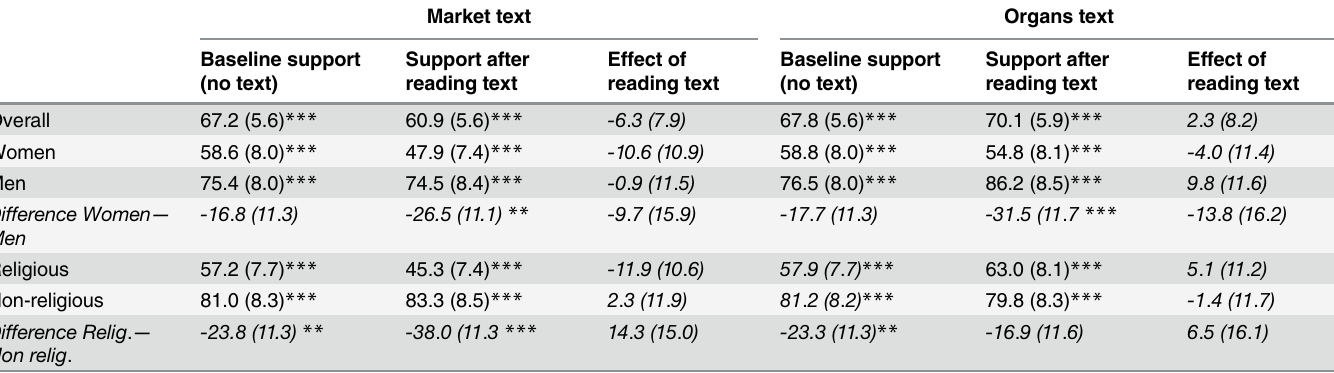
Table 4. Regression estimates, heterogeneous effects: Support for legalizing